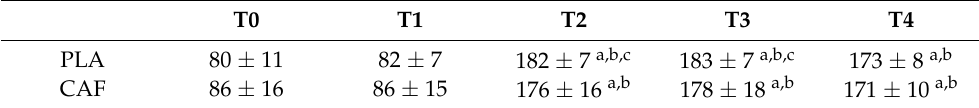
Table 3. Results of heart rate.